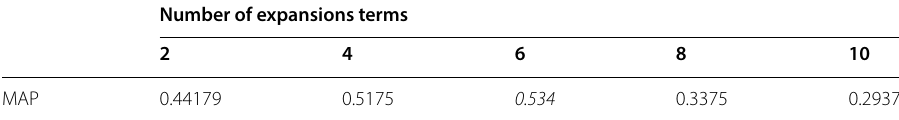
Table 6 Performance versus a number of expansions